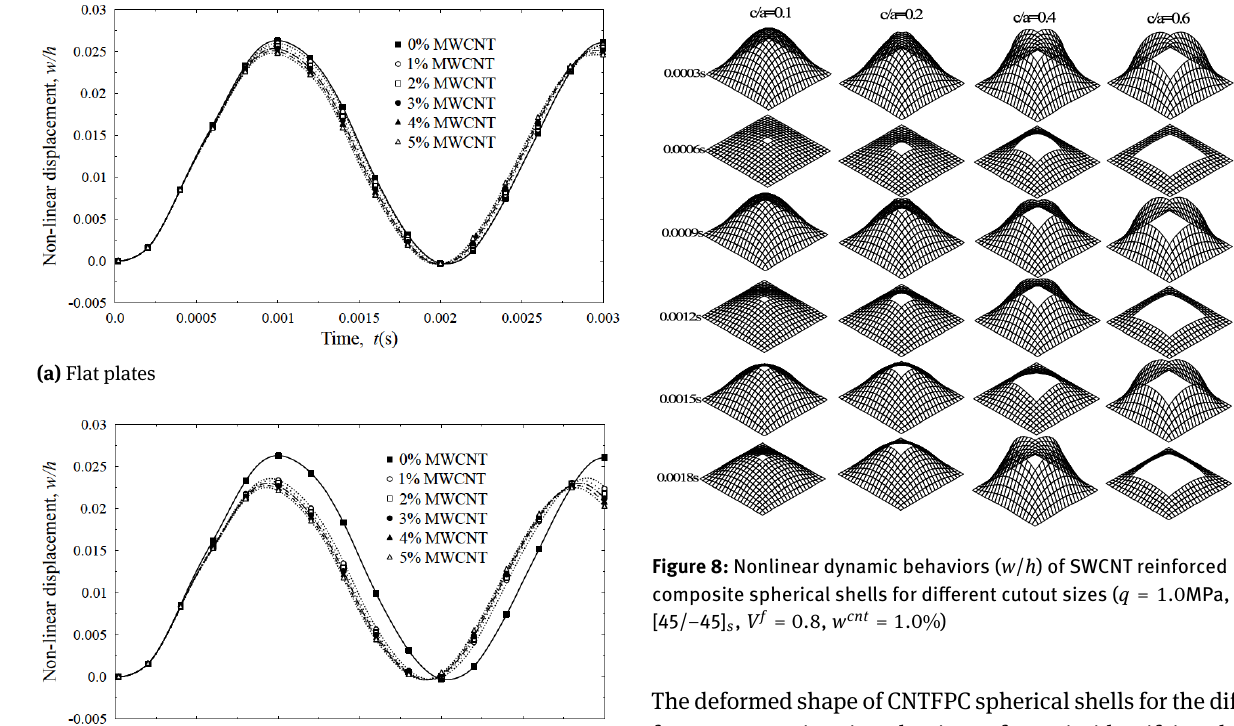
Figure 8 represents nonlinear dynamic behaviors of [45/−45] SWCNT reinforced composite spherical shells for s different cutout sizes. A distributed step loading of load- ing of magnitude q = 1.0MPa is applied at time t = 0.